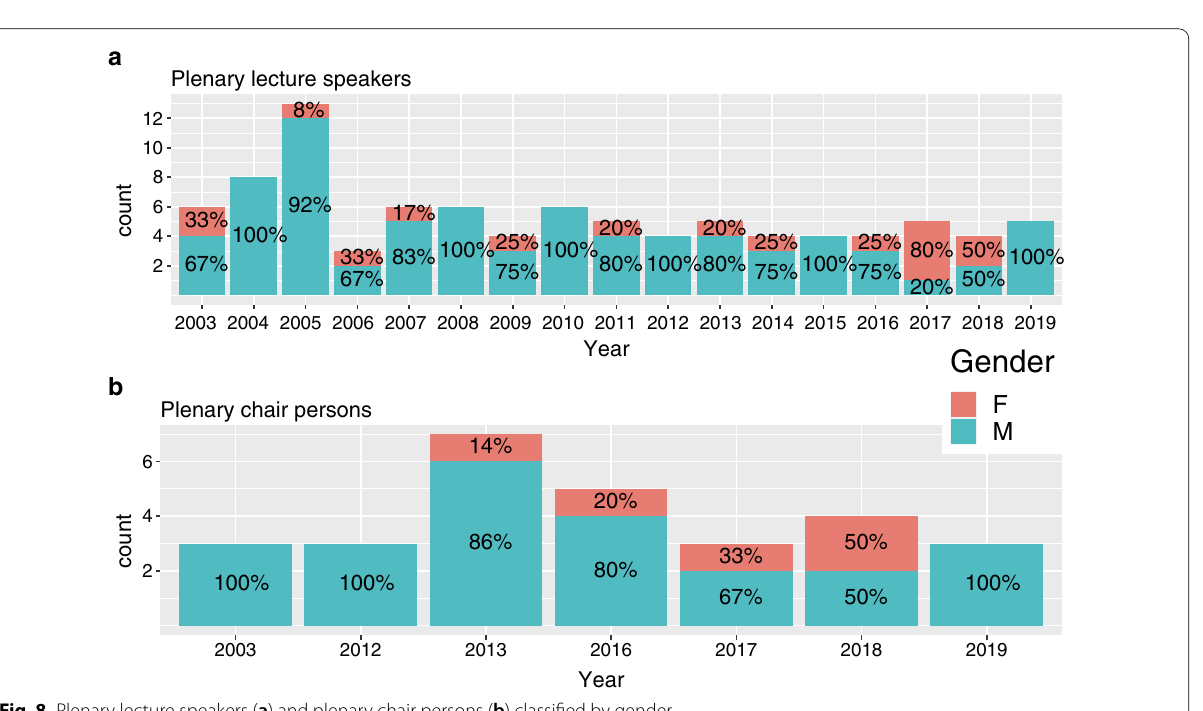
Fig. 8 Plenary lecture speakers ( a ) and plenary chair persons ( b ) classified by